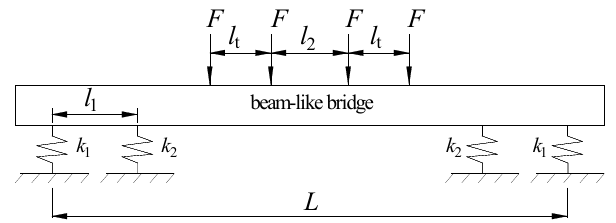
Figure 2. Schematic representation of a simplified mechanical model.